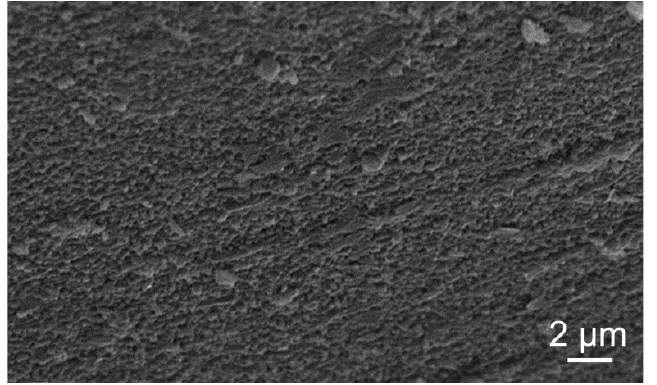
Figure 12. Homogeneous globular structure in Torellella sulcata from the upper Cambrian of Esto- nia.